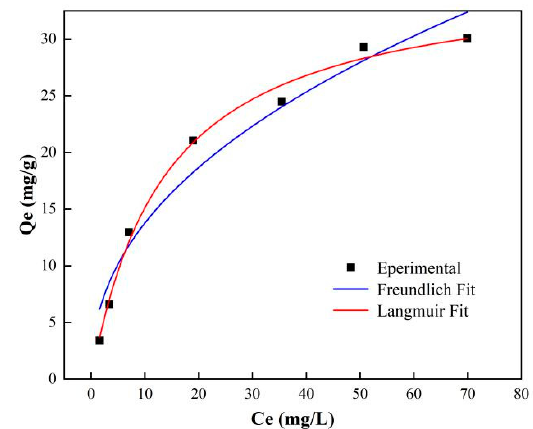
Figure 5. The isotherm for levofloxacin (LVF) adsorption on CuFe2O4/MMT-k10, as well as Langmuir and Freundlich isotherm model fittings.